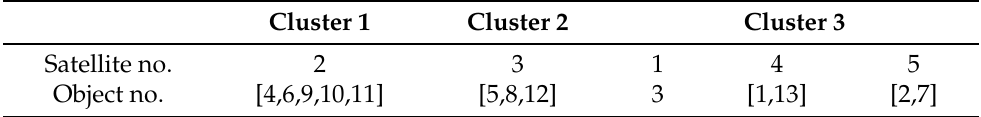
Table 5. Updated task-planning results of example in case of urgent task using first task-replanning